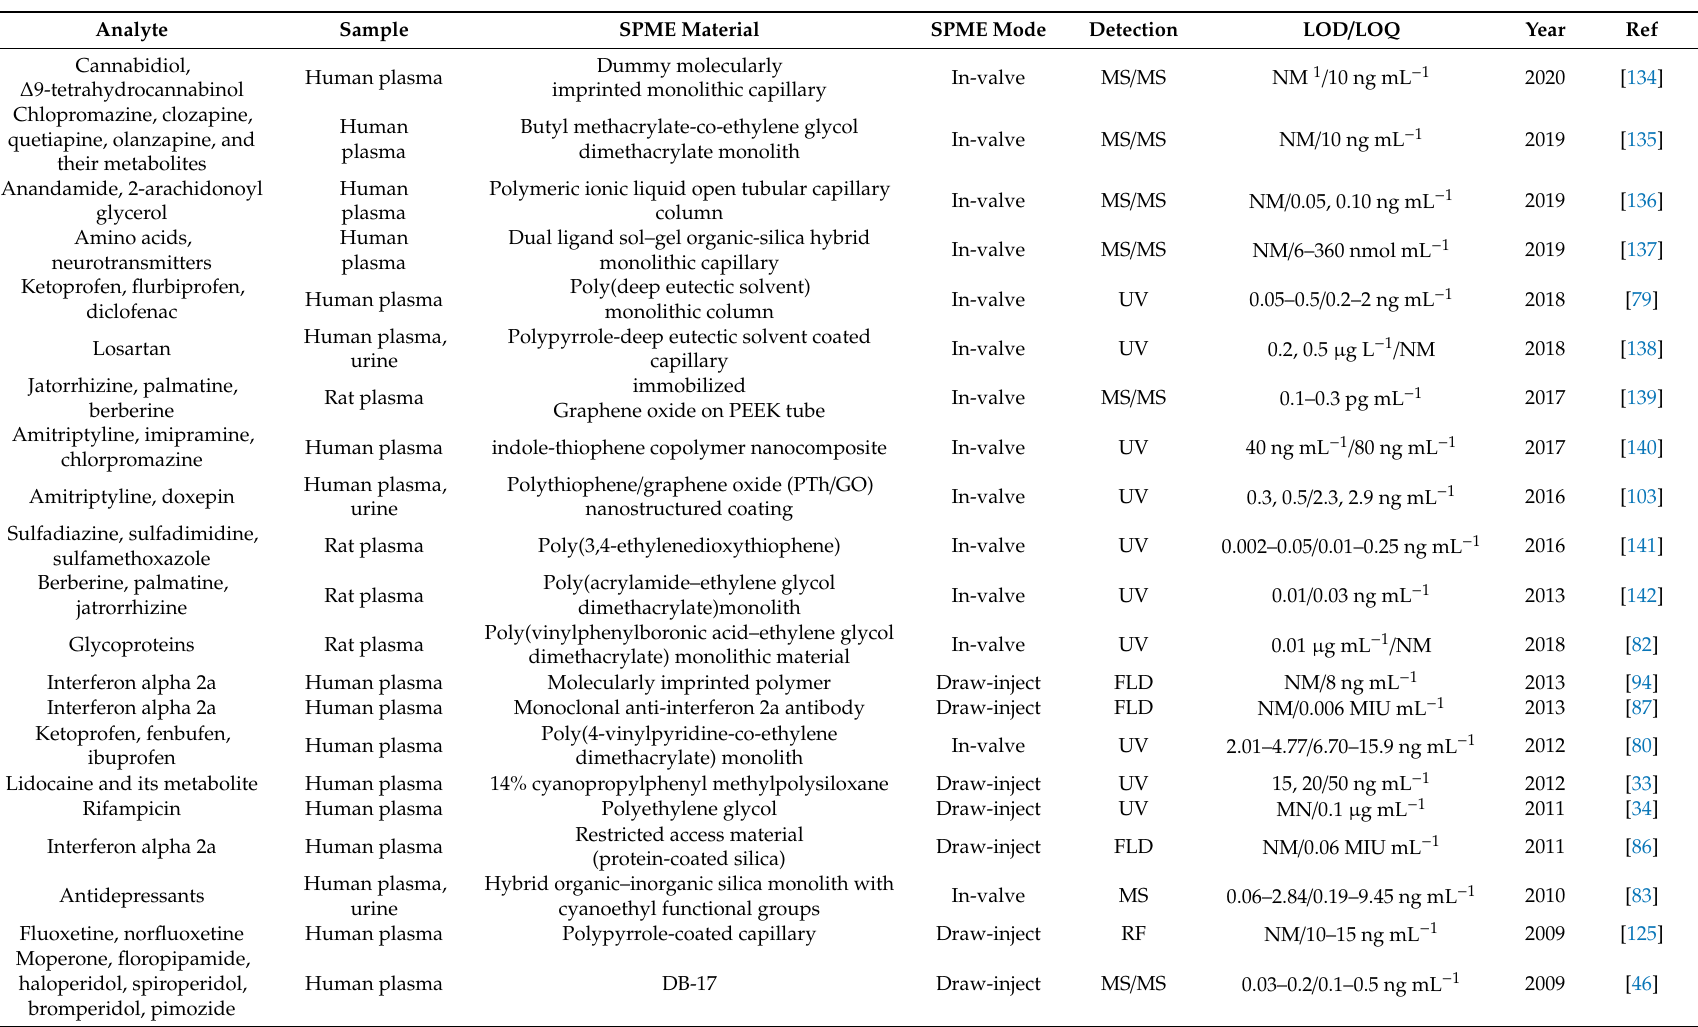
Table 1. Bioanalytical HPLC applications of in-tube SPME for the determination of